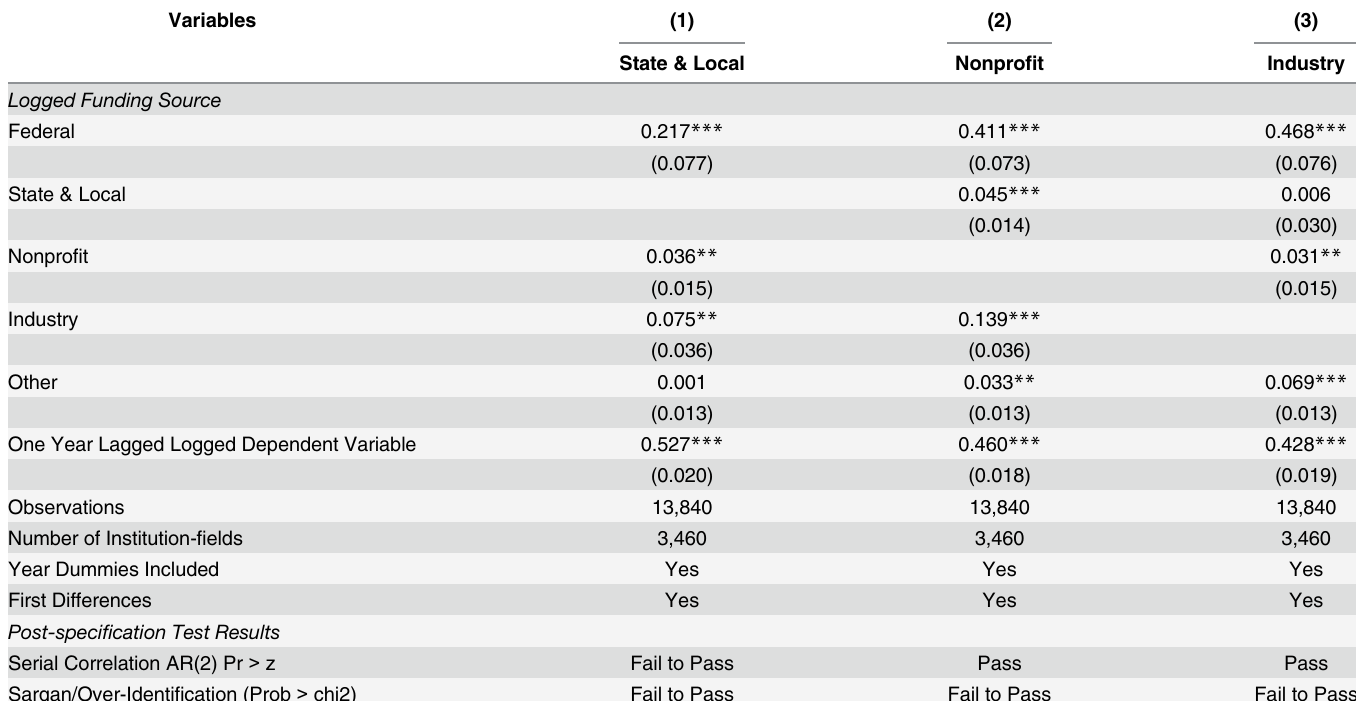
Table 3. Dynamic Panel Model Results by Outcome (Eq